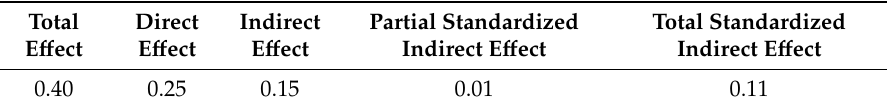
Table 5. Model e ff ect Table 5. Model effect indices.